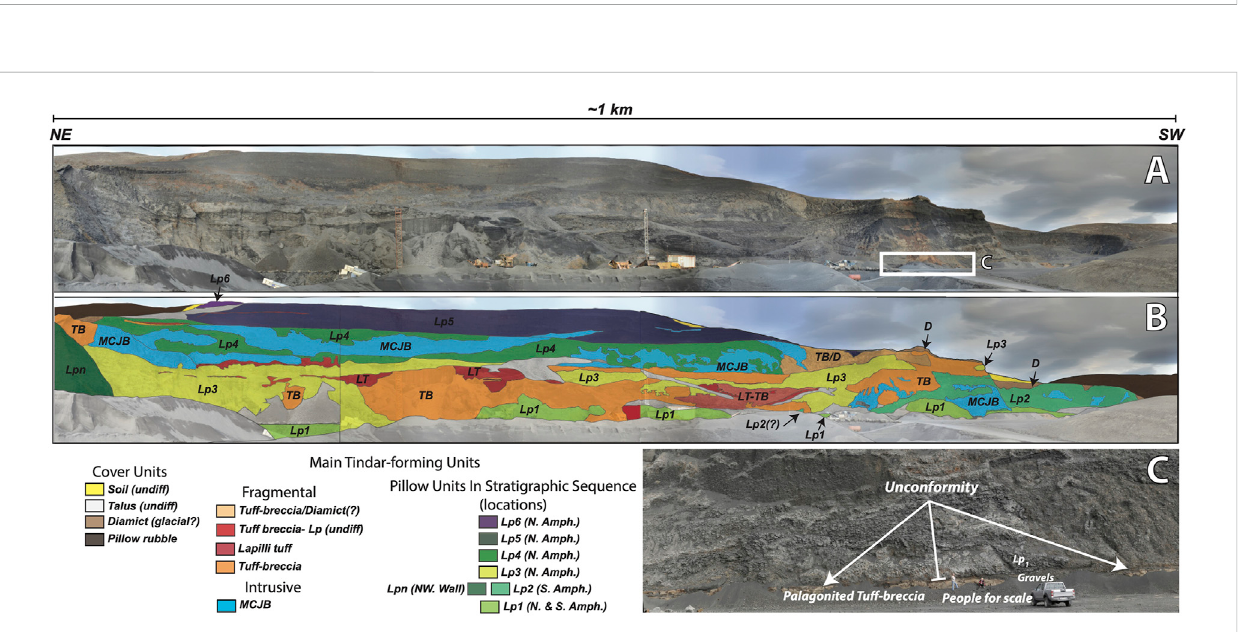
volcanic stratigraphy with multiple pillow and fragmental units, to capping sedimentary units (Figure 3). The basal contact is exposed near the center of the walls, where the lowest pillows (Lp1) appear in lenses that lie unconformably over sedimentary layers of yellow diamict containing cobble-sized clasts of vesicular basalt. The upper